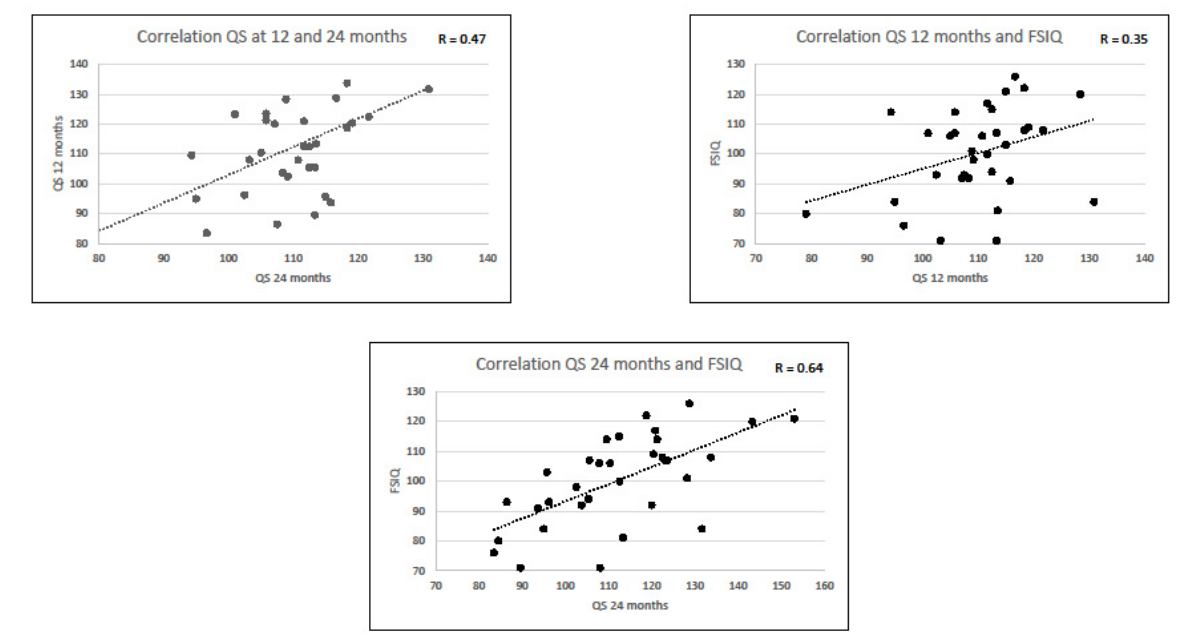
Figure 1. Correlation between Griffiths and the WPPSI-III scores.